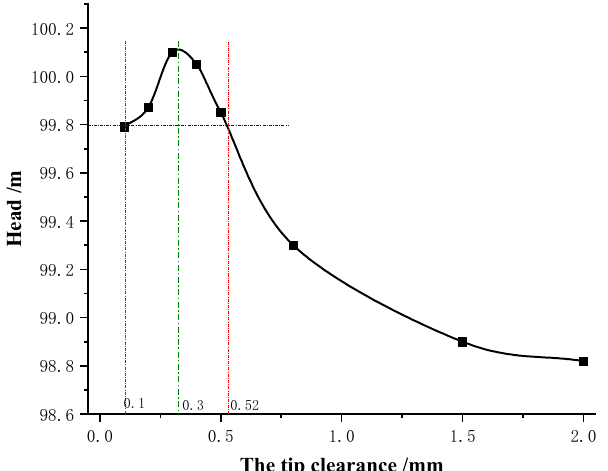
Figure 8. Head of the Centrifugal Pump under Various Tip Clearance Conditions.